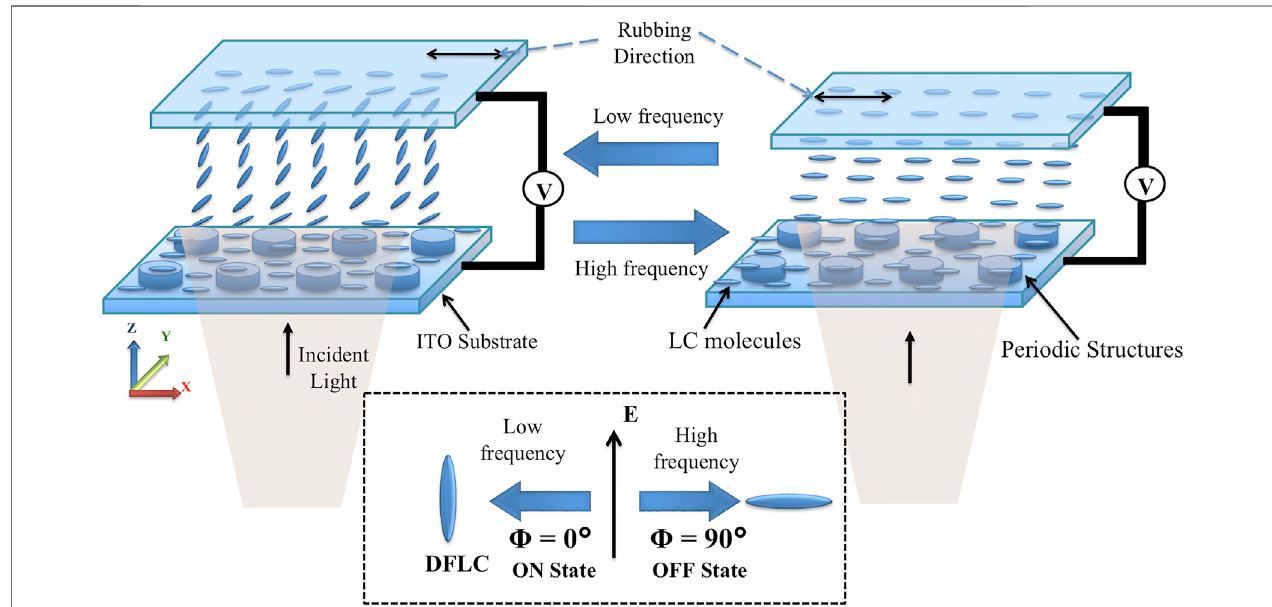
FIGURE 1 | Schematic of metasurface device with DFLC operated between low frequency, f L (left) and high frequency, f H (right).